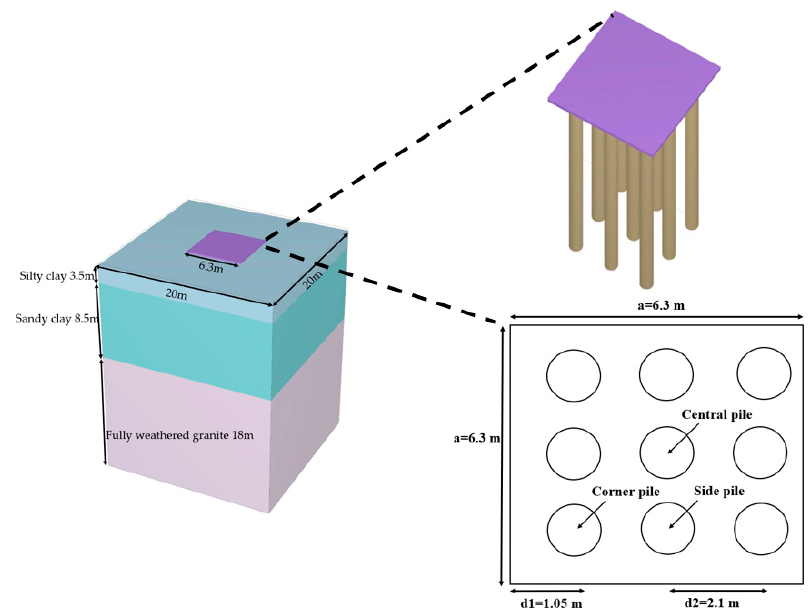
Figure 12. Finite element model of group pile.